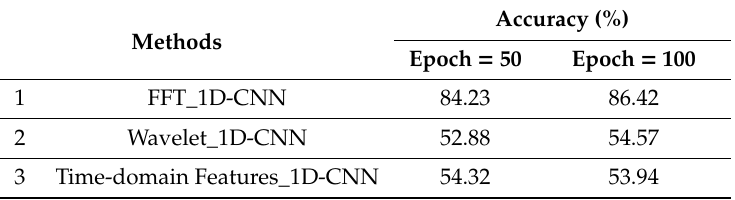
Table 8. The fault detection performance of the proposed methods on the test